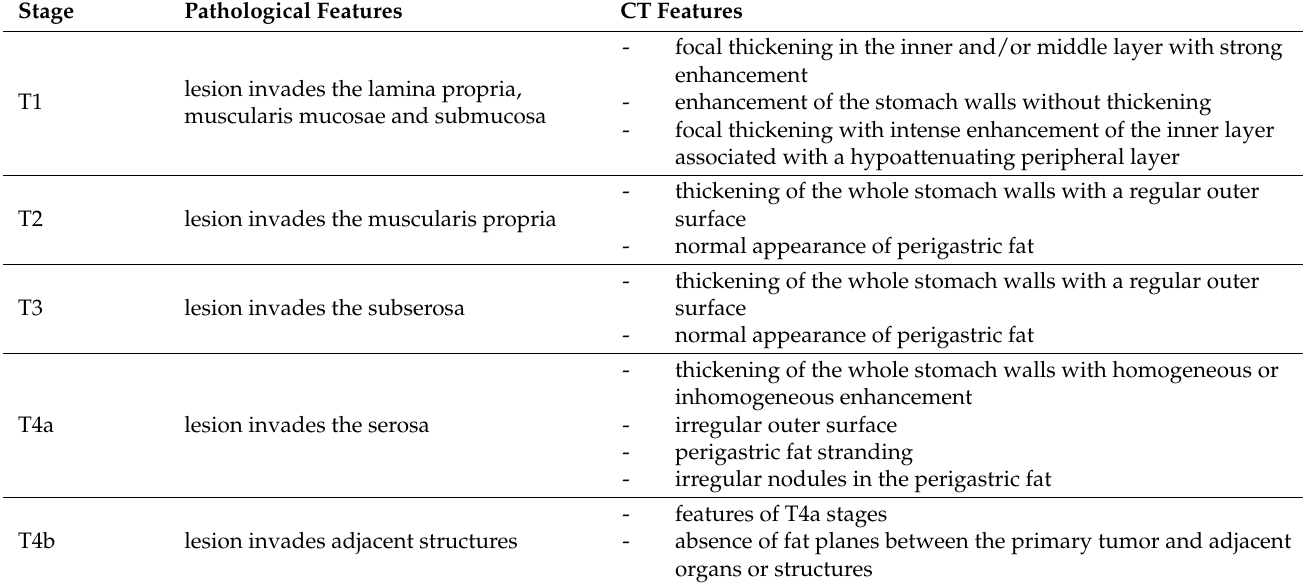
Table 2. CT criteria for T staging in gastric cancer patients. Adapted from [24].